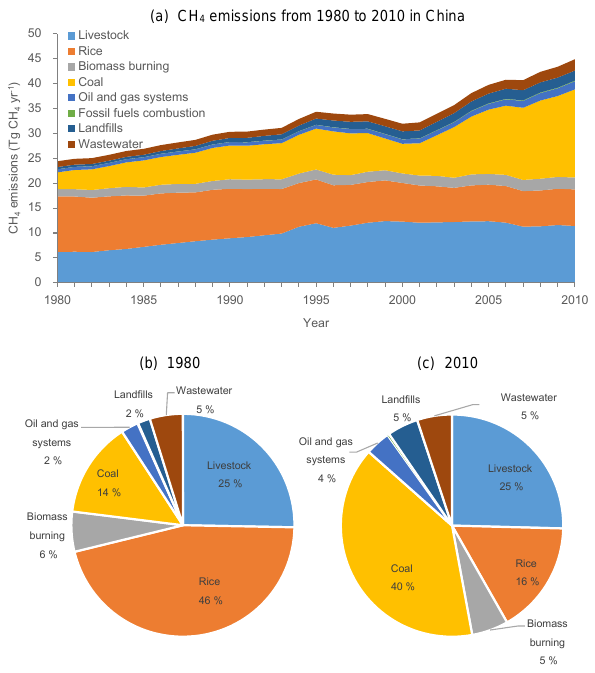
Figure 1. (a) CH 4 emissions from the eight major source sectors during the period 1980–2010 in mainland China. Pie diagram of CH 4 emissions (%) in (b) 1980 and (c)